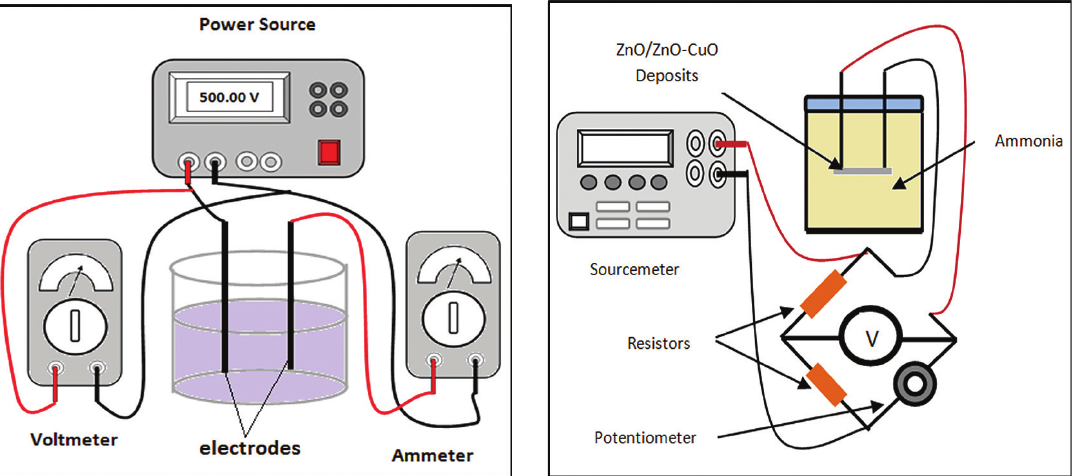
Figure 1. Schematic of EPD set-up. Figure 2. Wheatstone bridge gas sensing